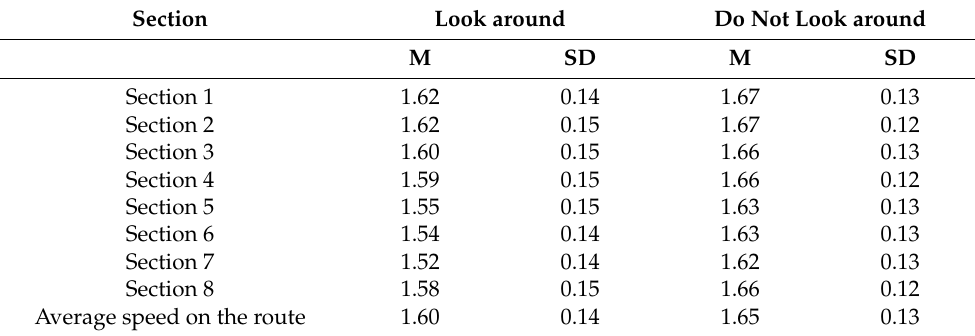
Table 4. The average walking speeds (m/s) in specific sections of the route in Study 3.